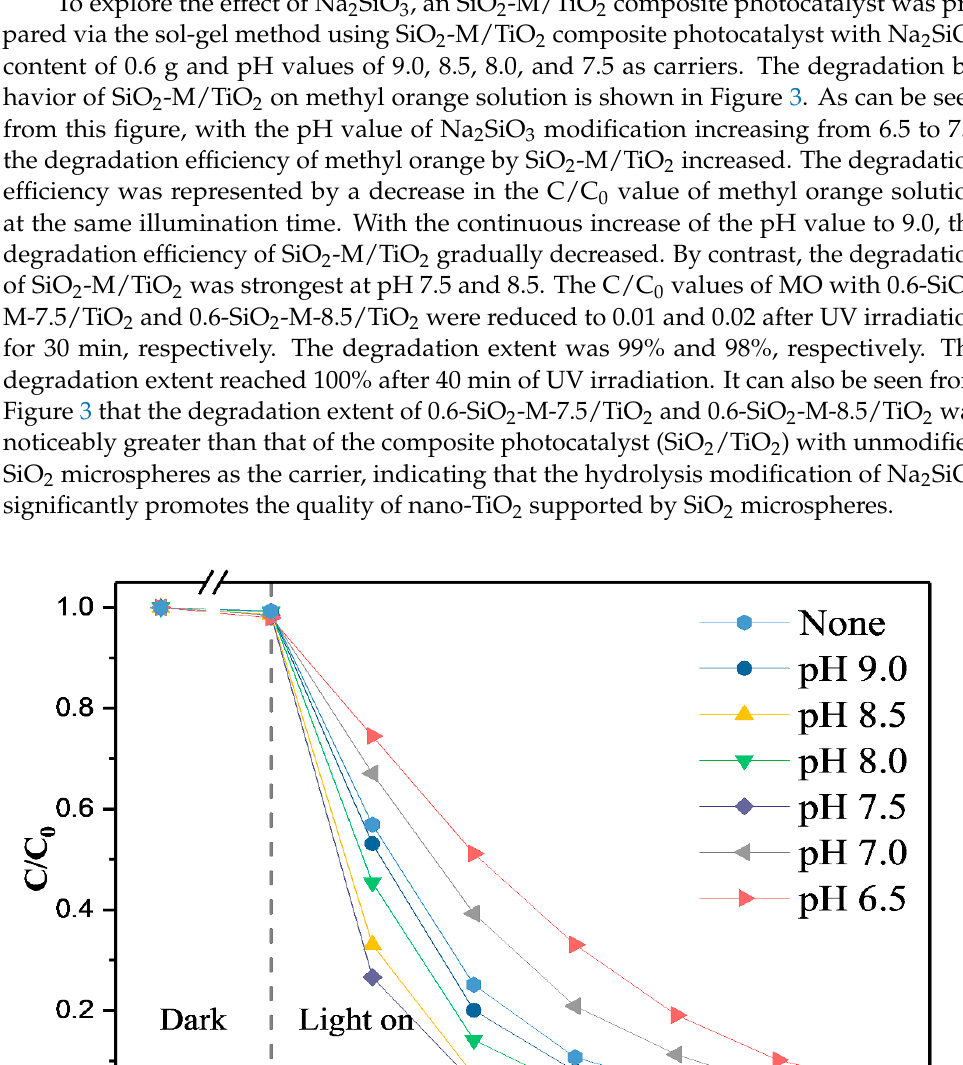
Table 1. Number of surface hydroxyl groups of SiO 2 microspheres before and after modification. Sample